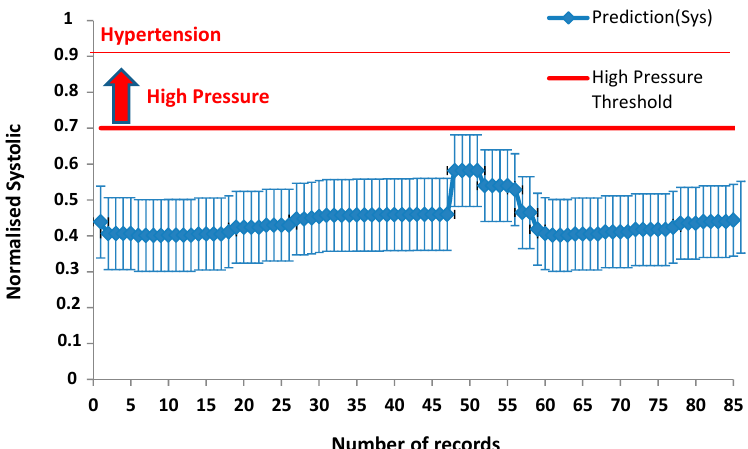
Figure 11. KNIME MLP prediction results of systolic values.